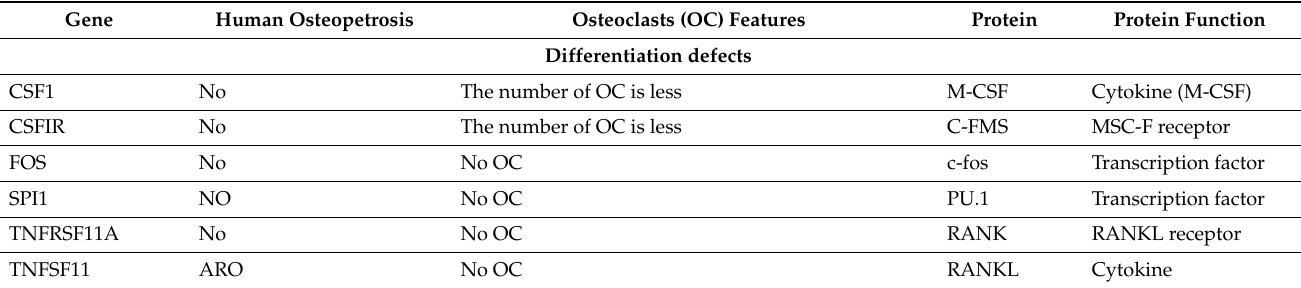
Table 1. Mutations in human